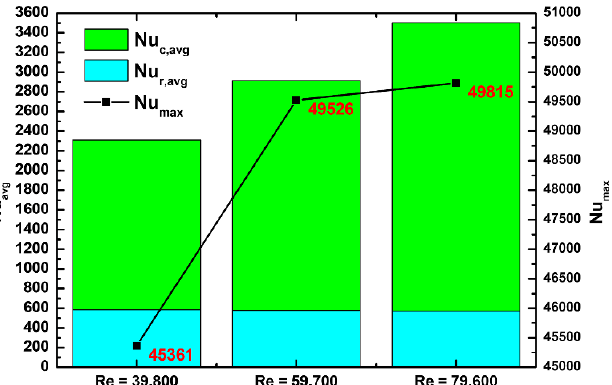
Figure 14. Variation of average Nusselt number of wall_1 with Reynolds number.